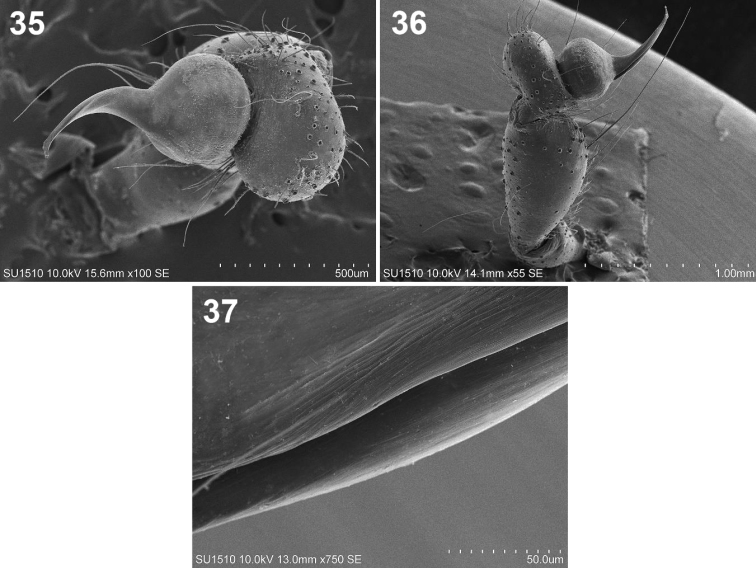
Loxosceles
tenochtitlan sp. nov. Male paratype 35 right palp, tarsus, bulb and embolus, dorsal view 36 right palp, retrolateral view 37 detail of the canal along the embolus.